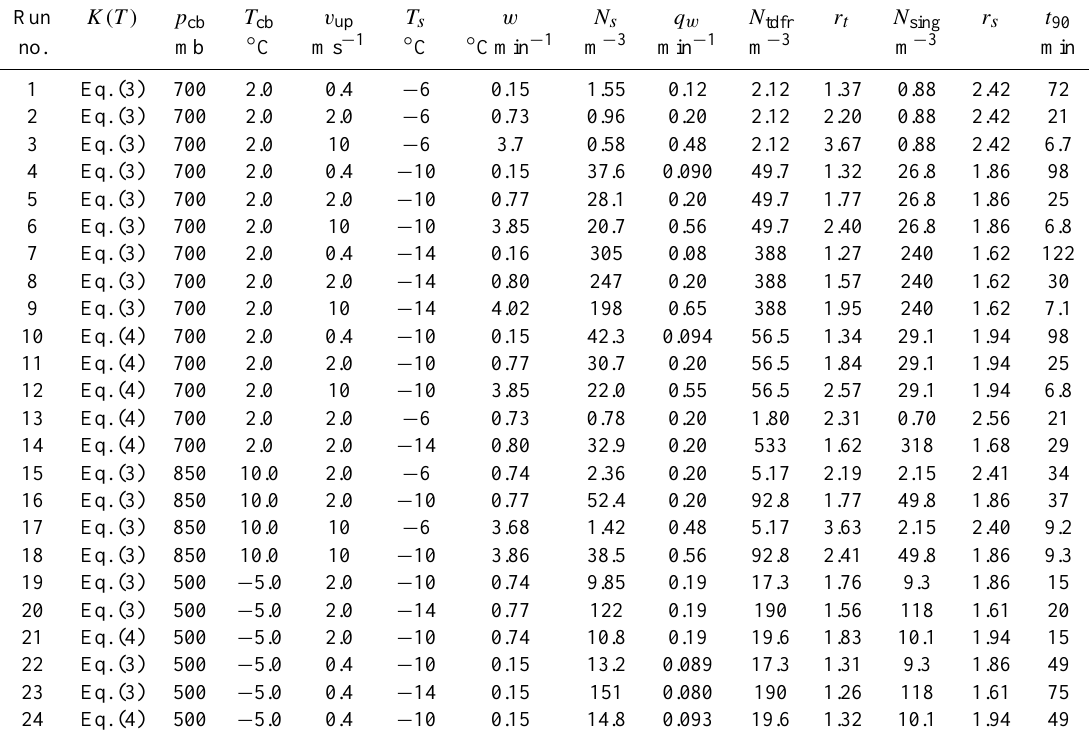
Table 1. Ice particle concentrations obtained with the TDFR model under different initial conditions. Symbols stand for the following: K(T ) is the nucleus spectrum given by either Eqs. (3) or (4); p cb and T cb define cloud base conditions; v up is the assumed updraft velocity; T s is the temperature, N s is the ice concentration and w is the cooling rate when the parcel reaches the isothermal level; q w is the value of the decay constant of the freezing rate from Eq. (8); N tdfr is the asymptotic value of the ice concentration for the isothermal period; r t = N tdfr N sing is the ice concentration predicted by a singular interpretation of K(T ) ; r s = N tdfr level for 90% of the asymptotic ice concentration to be